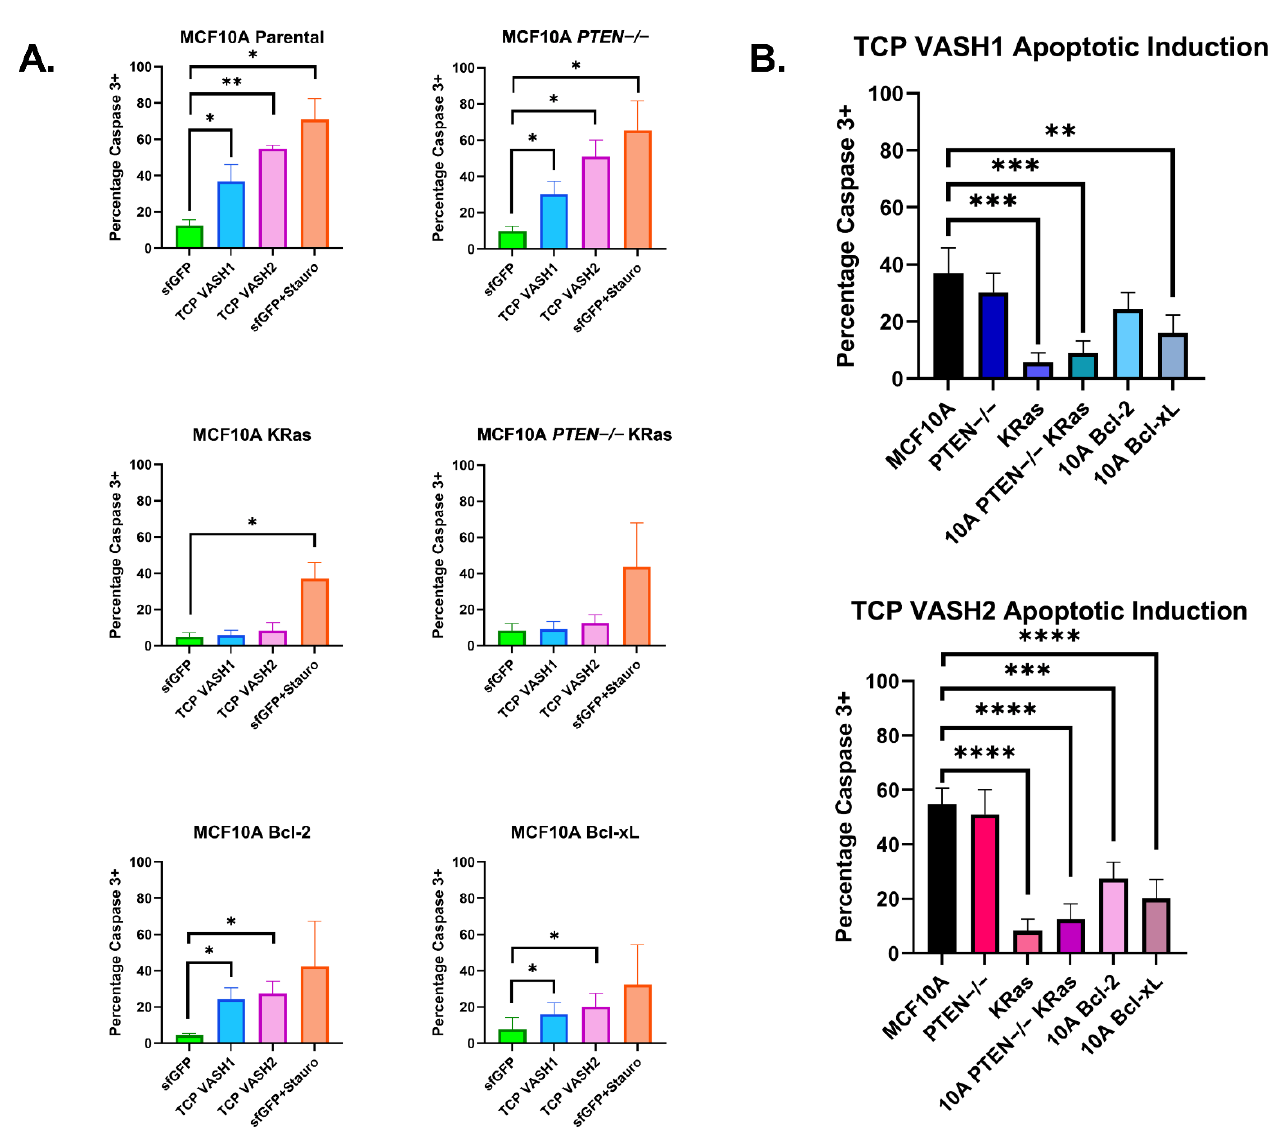
Figure 4. TCP transfection induces apoptosis that is blocked by oncogenic KRas, Bcl-2 and Bcl-xL overexpression. ( A ) Specific oncogenic or anti-apoptotic signaling pathways were manipulated in the stable background of MCF10A cells. These cell lines were then transfected with sfGFP control, TCP- VASH1 , or TCP- VASH2 for 24 h. After 24 h, the cells were fixed and stained with an anti-active Caspase-3 antibody and AF594-conjugated secondary to determine cells actively undergoing apoptosis. Using the HCA Nikon Analysis software, sfGFP -positive cells were identified and then average intensity of the AF549 signal for each sfGFP -positive object was determined. If the AF549 average intensity was greater than 10,000 RFU, that object was counted as positive for active Caspase-3. Cells transfected with TCP- VASH1 and TCP- VASH2 had a higher level of Caspase-3 activation compared to the sfGFP control in MCF10A parentals, PTEN − / − , Bcl-2- and Bcl-xL-overexpressing cells. Interestingly, MCF10A KRas and PTEN -/ KRas did not show an increase in Caspase-3 activation compared to sfGFP control. ( B ) For each TCP construct ( VASH1 or VASH2 ), the level of Caspase-3 activation was compared to sfGFP . Oncogenic KRas provides the most protection against TCP-induced cell death, but Bcl-2 and Bcl-xL also provide a lesser level of protection. * p < 0.05, ** p < 0.01, ***, p < 0.001, and **** p < 0.0001, n = 4; triplicate.